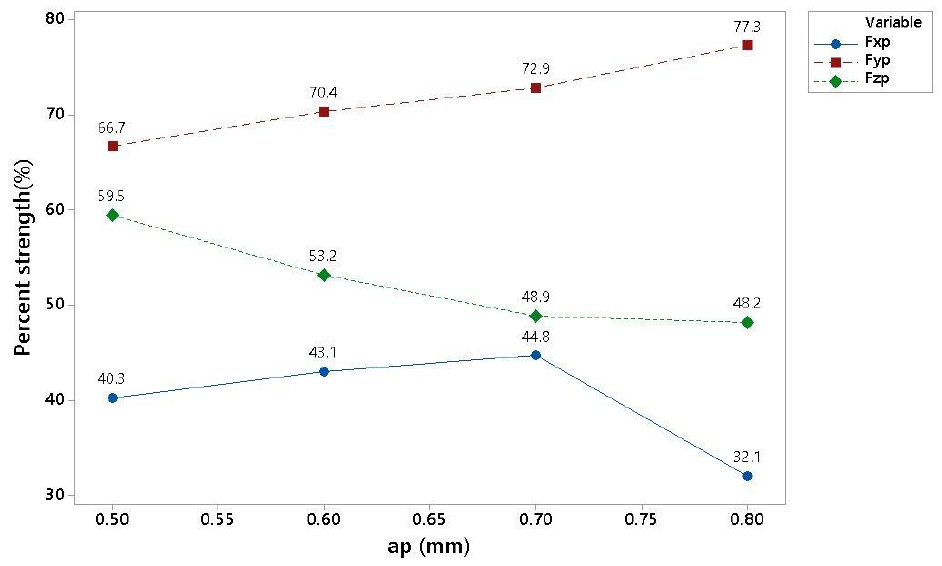
Figure 8. Graphical display of the results for various cutting conditions.